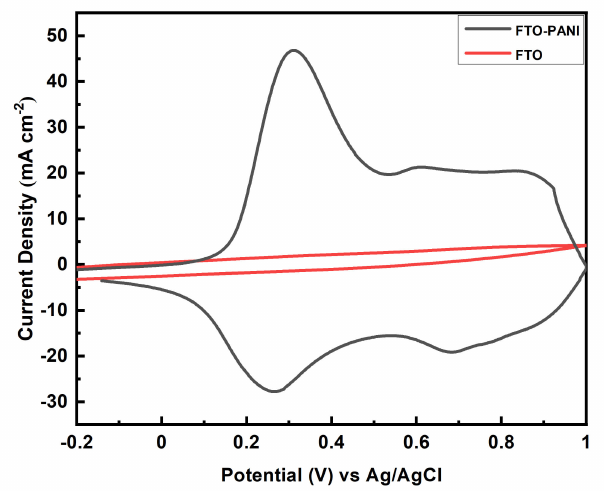
Figure 5. Cyclic voltammogram of FTO (black line) and binder free FTO-PANI (red line) in 1 M H 2 SO 2 vs Ag/AgCl (KCl sat in H 2 O) at 20 mVs − 1